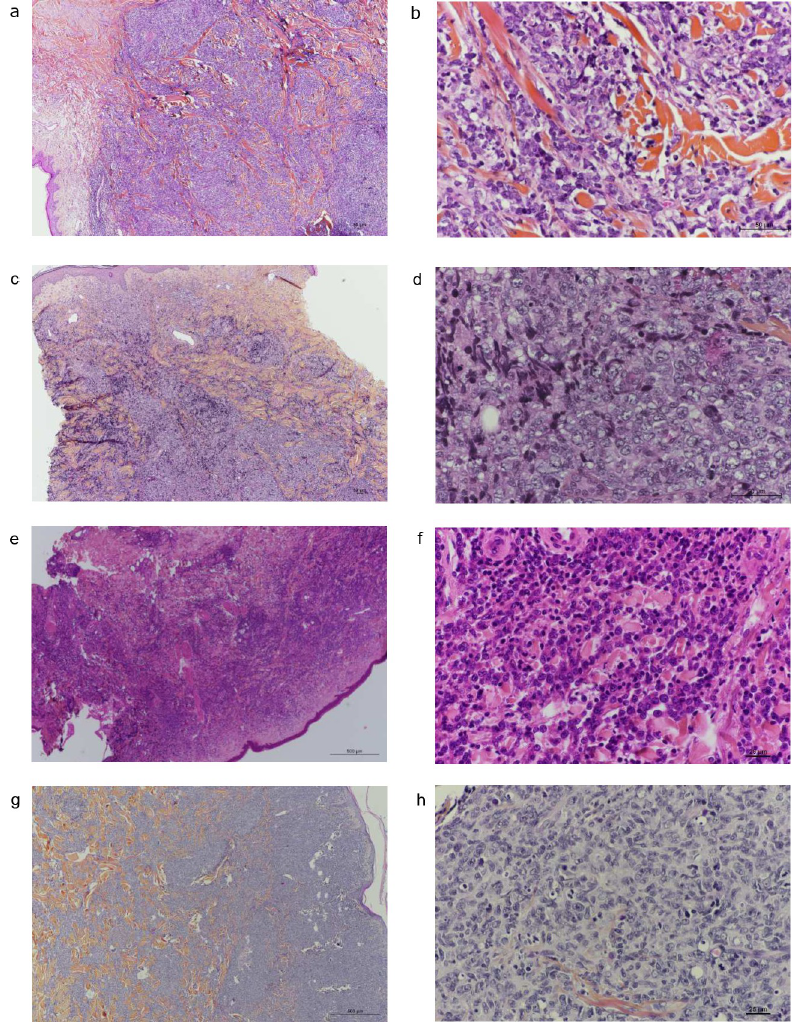
Fig 1. Histopathological aspects of PCLBCLs. a. PCFCL, LC (LC-1): HES x4: nodular and diffuse lymphoid dermal infiltrate. b. PCFCL, LC (LC-1): HES x40: large tumoral cells with cleaved or elongated nuclei. c. PCLBCL, LT (LT-23): HES x4: nodular and diffuse lymphoid dermal infiltrate. d. PCLBCL, LT (LT-23): HES x40: large tumoral cells with a mixture of centroblasts and immunoblasts. e. PCLBCL, LT (LT-2): HES x4: nodular and diffuse lymphoid dermal infiltrate. f. PCLBCL, LT (LT-2): HES x40: large tumoral cells with a predominance of immunoblasts. g. PCLBCL, NOS (NOS-1): HES x4: nodular and diffuse lymphoid dermal infiltrate. h. PCLBCL, NOS (NOS-1): HES x40: large tumoral cells with either centroblastic, immunoblastic or cleaved cytology. HES: Hematein-Eosin-Saffron; PCLBCL, LT: primary cutaneous large B-cell lymphoma, leg type; PCFCL, LC: primary cutaneous follicle centre lymphoma, large cell; PCLBCL, NOS: primary cutaneous large B-cell lymphomas, not otherwise specified.